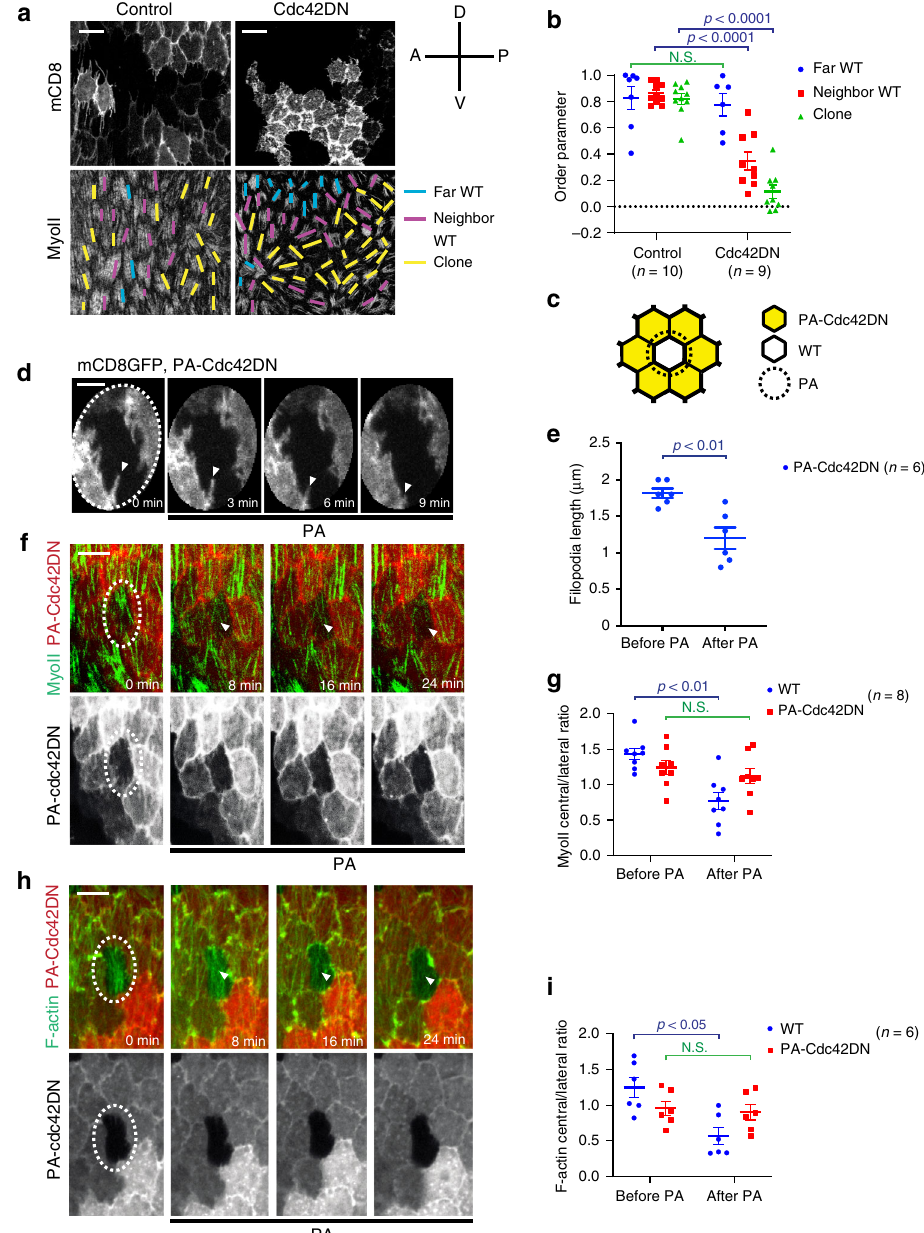
Fig. 5 Cdc42 has a non-cell autonomous role in stress fi ber organization. a Micrographs showing follicle cell clones not expressing (left panels) and expressing (right panels) the Cdc42DN transgene marked by mCD8GFP coexpression. MyoII is visualized by using a MyoII-mCherry construct. Yellow lines, purple lines and blue lines mark the orientation of the basal stress fi bers in the clone cells, in the wild-type cells that neighbor clone cells and in the wild-type cells that are not neighboring the clone cells, respectively. A-P and D-V indicate the anterior-posterior and ventral-dorsal axes. b Order parameter for the three types of follicle cells indicated from the n egg chambers not expressing (control, only mCD8GFP expressing) and expressing the Cdc42DN transgene. For the far WT comparison: p = 0.5338; for the neighbor WT comparison: p < 0.0001; for the clone comparison: p < 0.0001; all by two-sided Mann – Whitney test. c Schematic diagram showing the region of photoactivation (PA, dashed circle) in experiments where one wild-type cell is surrounded by PA-Cdc42DN-expressing clones. Only the sub-basal cell – cell contact zones of PA-Cdc42DN clones facing the wild-type cells are photoactivated. d , f , h Time-lapse series showing the experiment represented in c for PA-Cdc42DN-expressing clonal cells labeled with mCD8GFP ( d ), MyoII-GFP ( f ), and UtrABD-GFP ( h ), respectively. Dashed ellipses indicate the photoactivated region. Arrow heads indicate fi lopodia in d and medial-basal regions in f , h . e Average fi lopodia length per cell (from four egg chambers) measured before and 10 – 15 min after photoactivation in the n individual cells of the experiments represented in c and d . p = 0.0065 by two-sided Mann – Whitney test. g , i Relative (central/lateral) distribution of MyoII ( g ) and F-actin ( i ) in the n individual wild-type and PA-Cdc42DN-expressing cells before and 20 – 30 min after photoactivation as shown in c . For relative distribution of MyoII signal, the WT before- vs. after- photoactivation comparison: p = 0.0011, the PA-Cdc42DN before- vs. after- photoactivation comparison: p = 0.3282; for relative distribution of F-actin signals, the WT before- vs. after- photoactivation comparison: p = 0.0108, the PA-Cdc42DN before- vs. after- photoactivation comparison: p = 0.6991; all by two-sided Mann – Whitney test. Data are presented as mean values + / − SEM. Scale bars are 10 μ m in a , f , h and 5 μ m in d